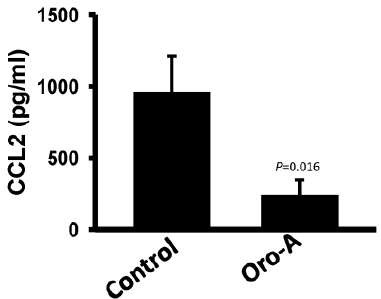
12 of 19 Figure 8 : Oro-A inhibits metastasis in vivo. ( A ) Mouse body weights were measured every 2 days, and the